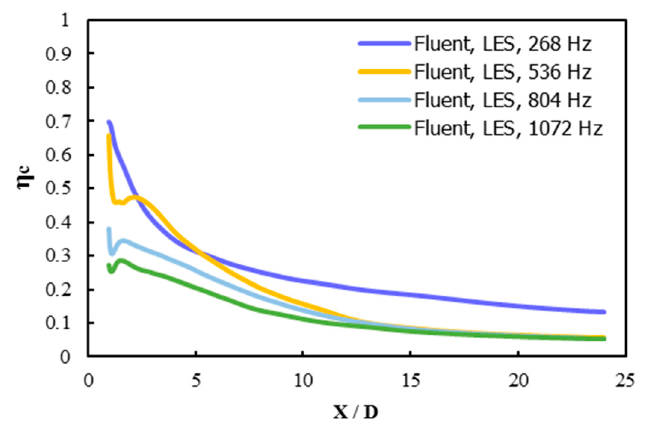
Figure 24. The centerline effectiveness obtained using the LES Smagorinsky–Lilly model for M = 0.5 for the 268, 536, 804, and 1072 Hz oscillations [28].